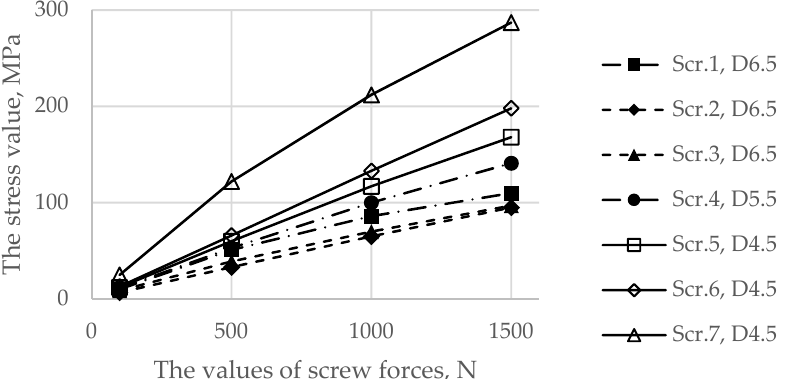
Figure 7. Dependence of the maximum von Mises stress in the screws as a function of the applied preload values.